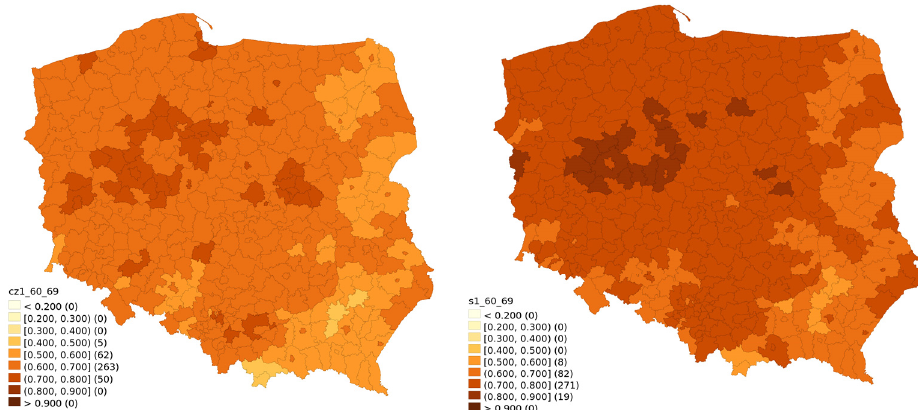
Figure 3. Vaccination rate for the 60–69 age bracket for 30 June 2021 and 31 January 2022.